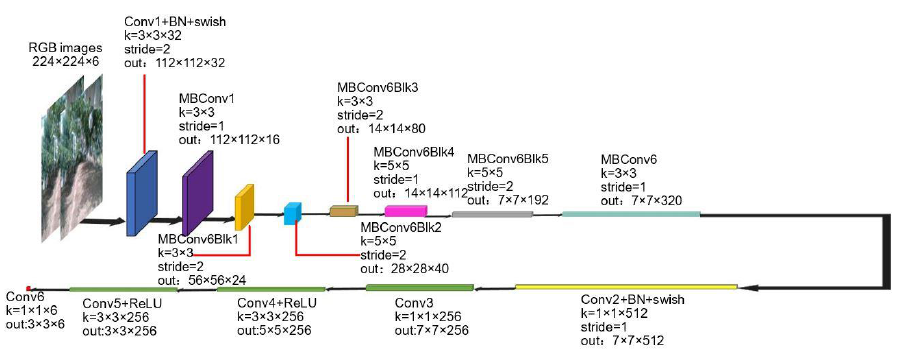
Figure 4. The pose estimate subnetwork.